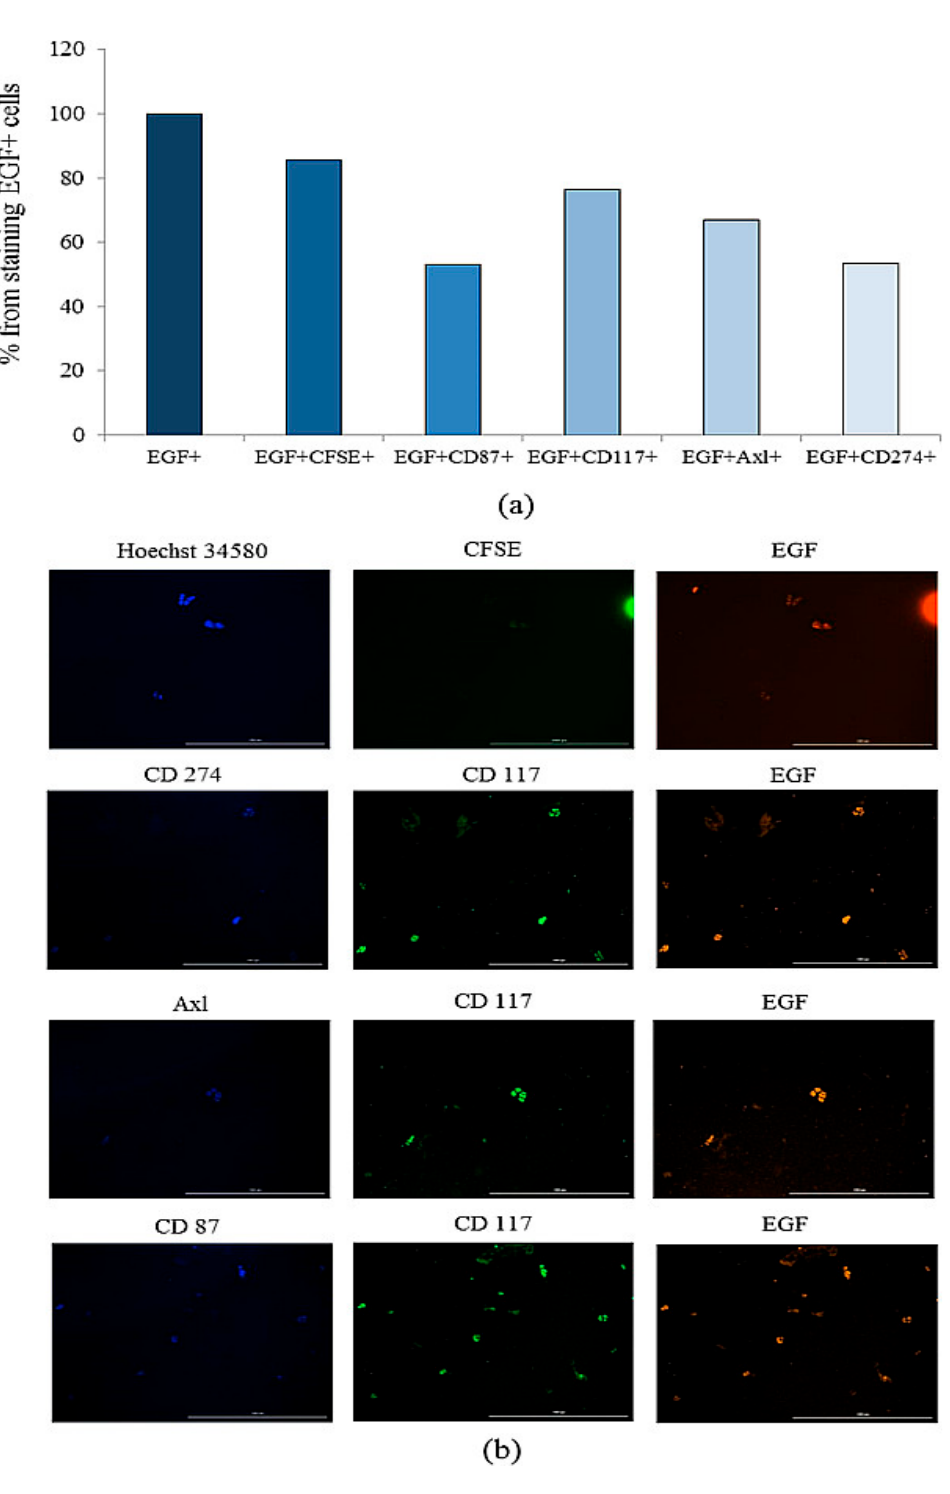
Figure 15. The evaluate of stained single cells in the culture of the adherent mononuclear fraction of patient G. ( a ) The number of cells positive for EGF, EFG/CFSE, EGF/CD87, EGF/CD117, EGF/Axl, and EGF/CD274; ( b ) 20× images of cells stained by: Hoechst 34580 (blue) to identify cell nuclei: CD87 (blue), CD274 (blue), Axl (blue), CFSE (green), CD117 (green), and EGF (yellow). All scale bars are 1000 µm. Cells were analyzed with the Cytation 5 multimodal imager using anti-human CD87 (BV421), CD117 (BB515), CD274 (BV421), Axl (BV421), and EGF (AF647) antibodies and CFSE fluorescent label.